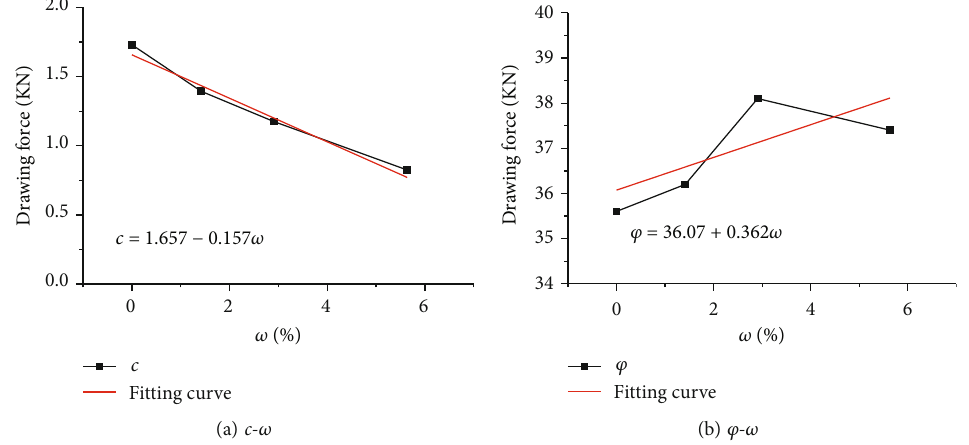
Figure 6: Fitting curve of c - ω and φ - ω about weakly cemented